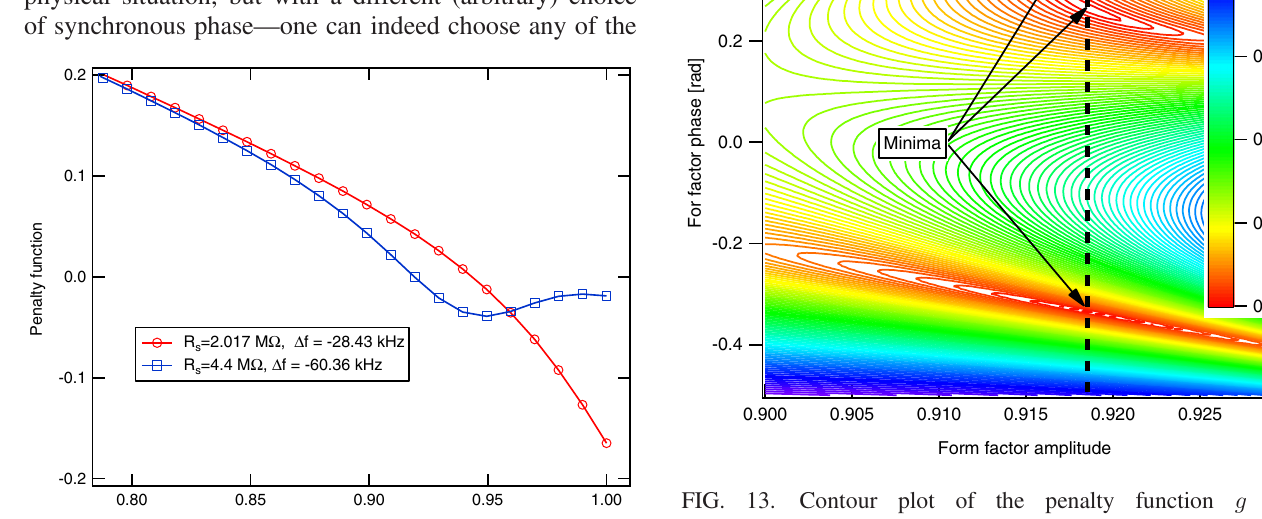
φ Þ ¼ V sin ð φ þ φ . The s Þ MC ð rf